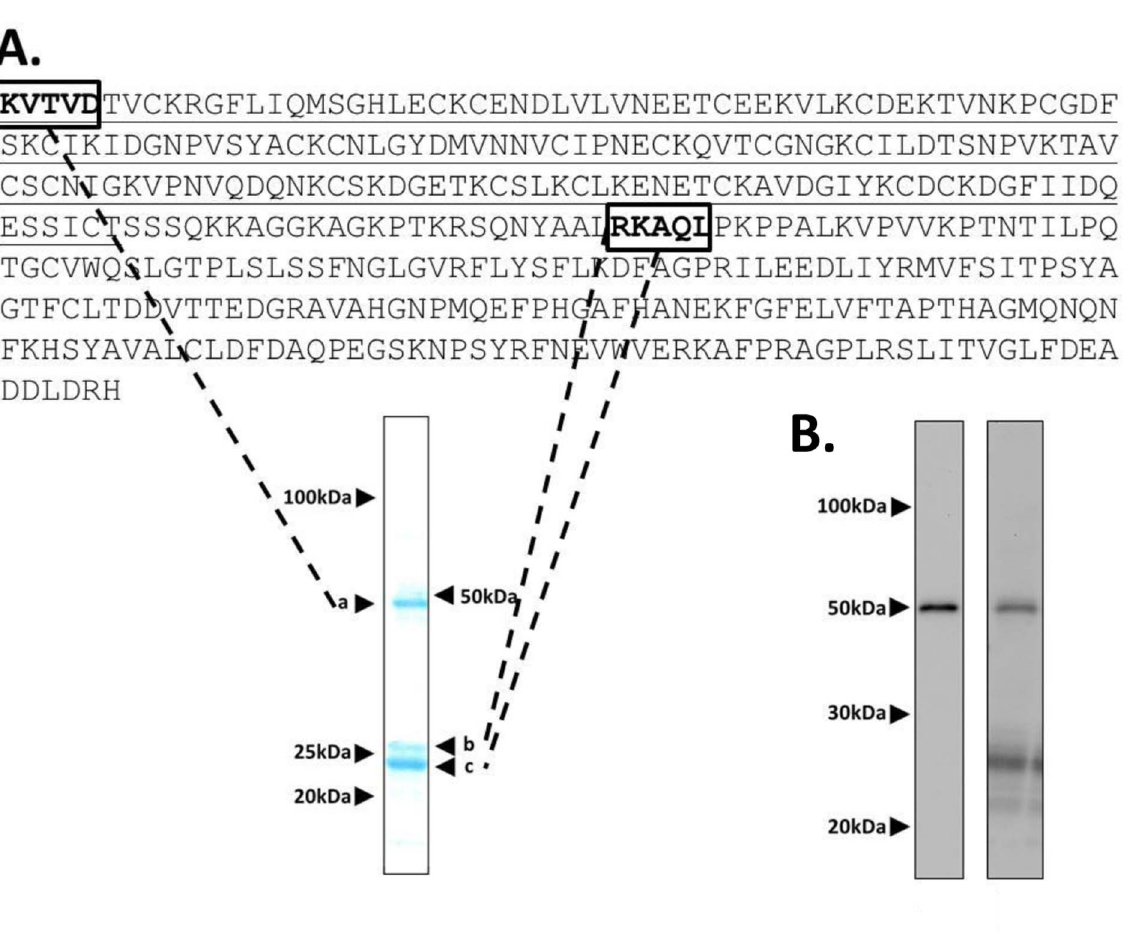
Figure 2. Pfs25-CP VLP purity and identity. (A) Deduced amino acid sequence of Pfs25-CP with Pfs25 sequence underlined. Amino acids boxed in the sequence were identified by N-terminal sequencing of the SDS-PAGE bands indicated. A Coomassie stain of an SDS-PAGE gel highlights the Pfs25-CP fusion polypeptide (arrowhead ‘a’) and CP monomer polypeptides (arrowheads ‘b’ & ‘c’). N-terminal sequencing of ‘a’ identified the first 5 amino acids of Pfs25, while sequencing of ‘b & c’ identified residue 26 of AlMV CP. (B) Western blot analysis of Pfs25-CP VLPs with an anti-Pfs25 mAb (left panel) and an anti-AlMV CP polyclonal serum (right panel).